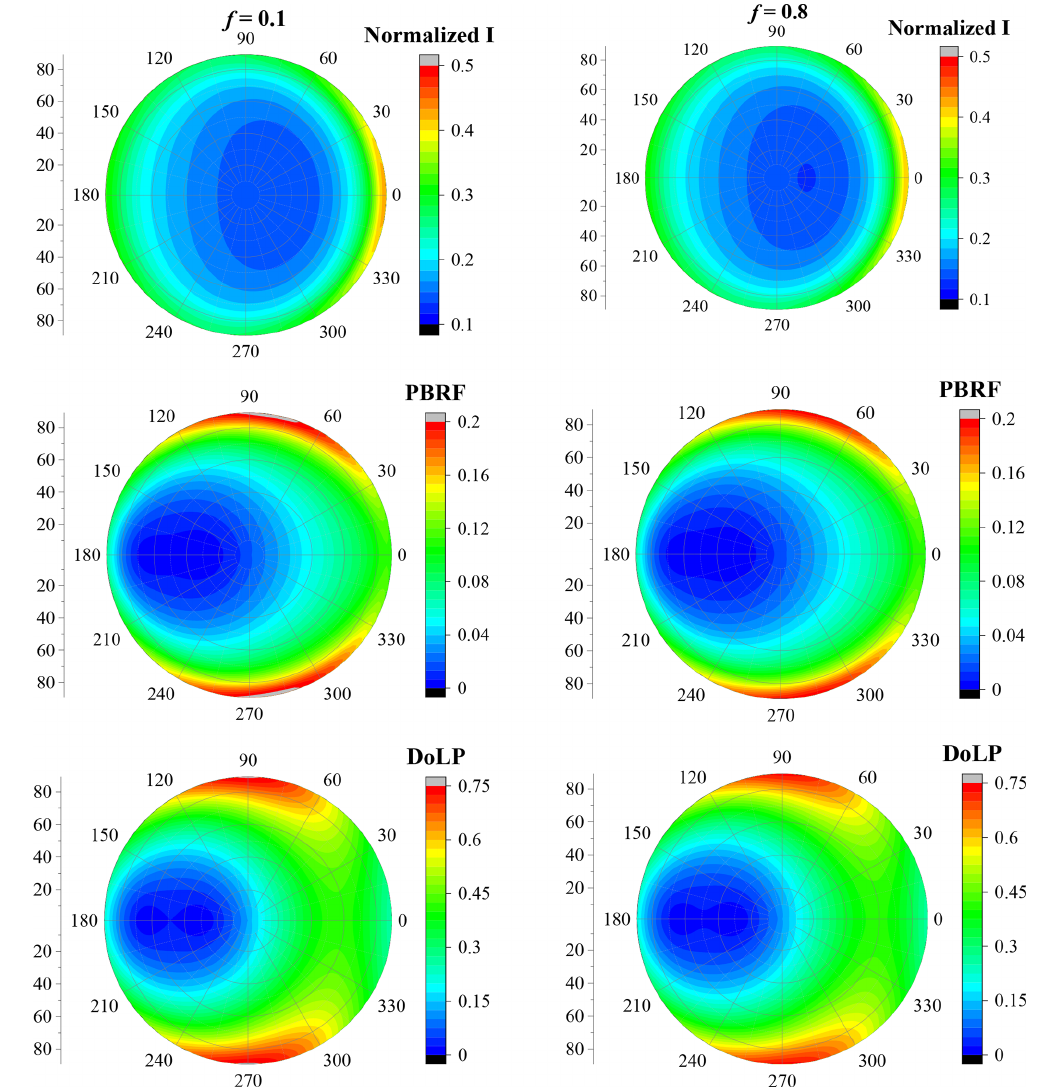
Figure 9. The polarimetric characteristics of dust with irregular shapes, where the aspect ratio is 2 : 1, d p = 0 . 2µm and R =